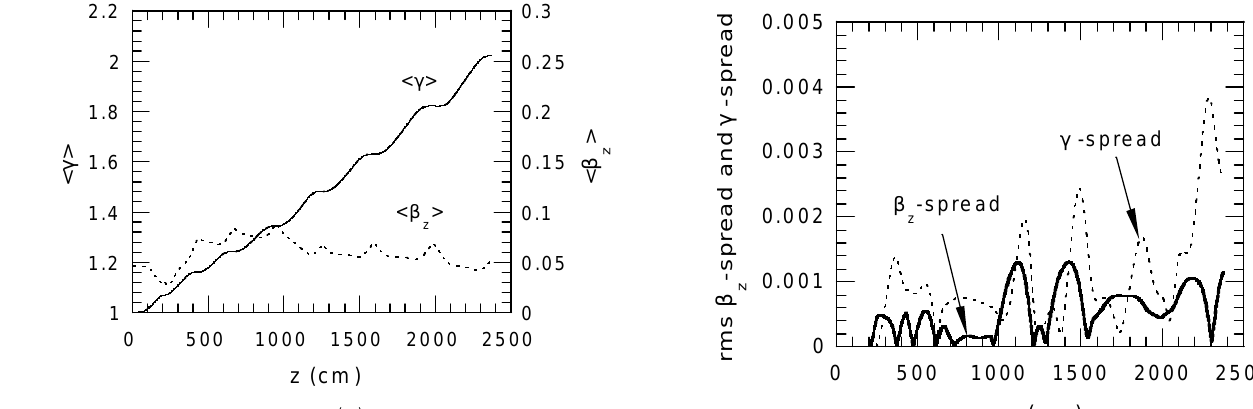
FIG. 2. Average energy factor (cid:6) g (cid:7) and average normalized ax- ial velocity (cid:6) b z (cid:7) vs z .